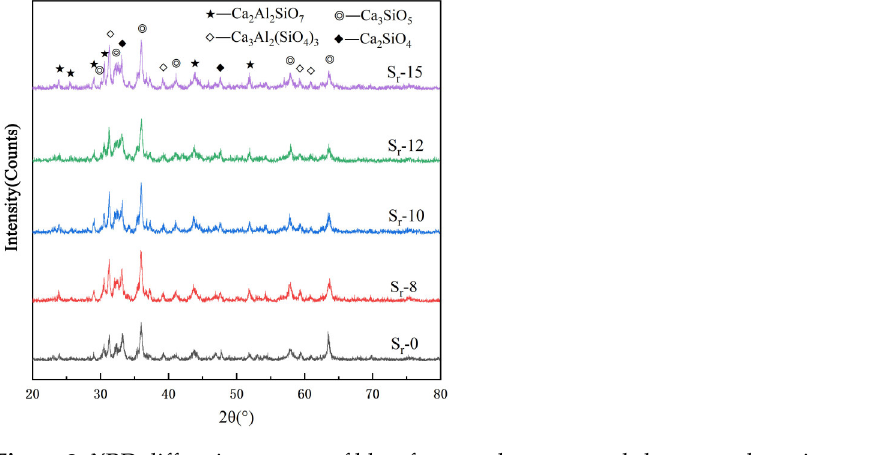
Figure 2. XRD diffraction pattern of blast furnace slag tempered slag roasted specimens.